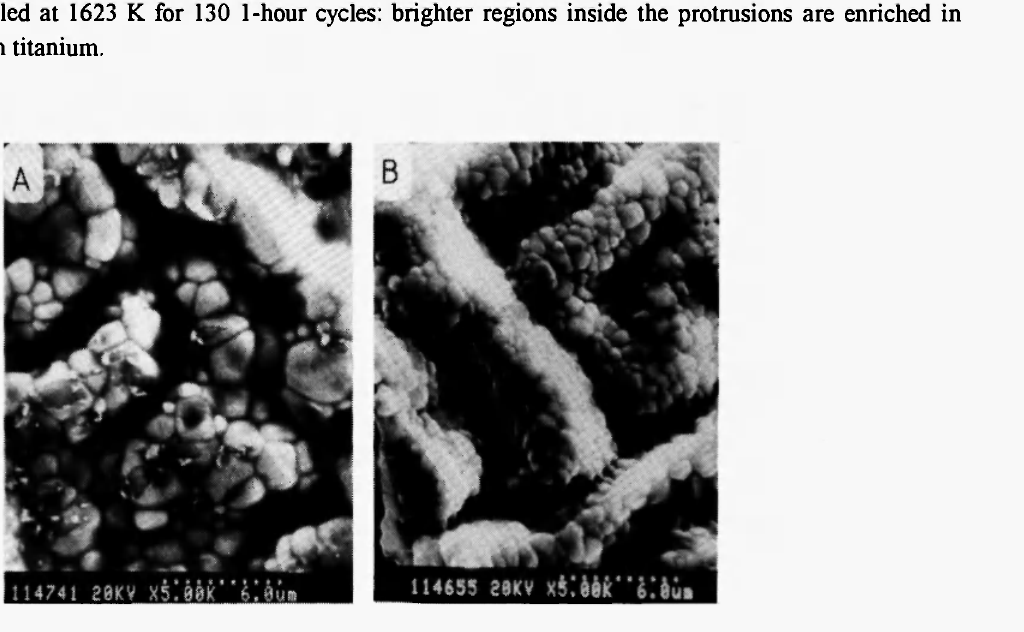
Fig. 16: Inner surface of the scale formed during 110 1-hour cycles at 1473 Κ on: A. alloy Fe-19Cr-5Al, and B. alloy Fe-19Cr-5Al+